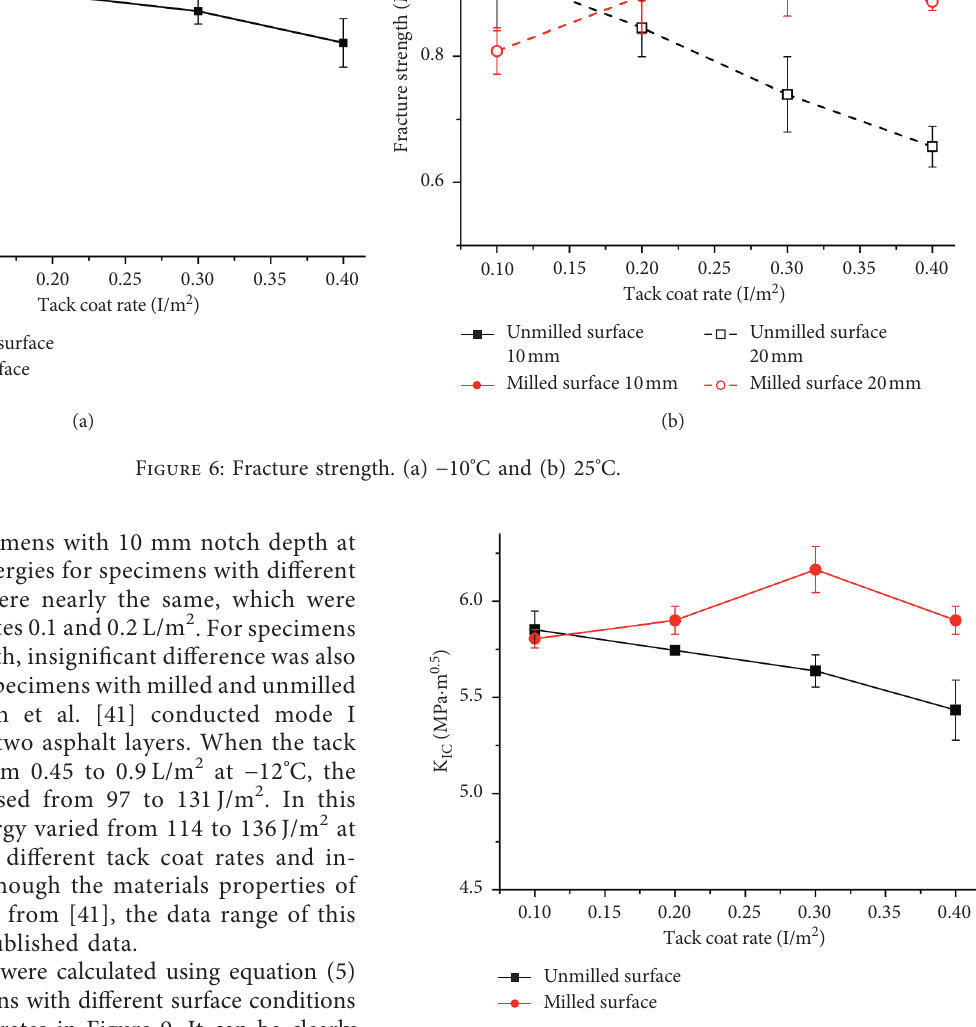
Figure 7: Stress intensity factors at − 10 ° C.